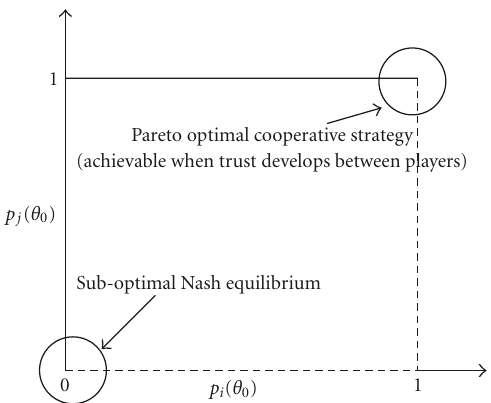
Figure 2: Best response functions in the mixed strategy noncoop- erative game. It can be seen that the strategy combination ( p i ( θ 0 ) = 1, p j ( θ 0 ) = 1) is attained when trust develops between the players which leads to the evolution of